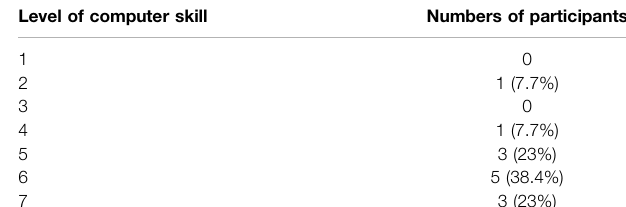
TABLE 7 | The level of computer skill of the participants who have provided